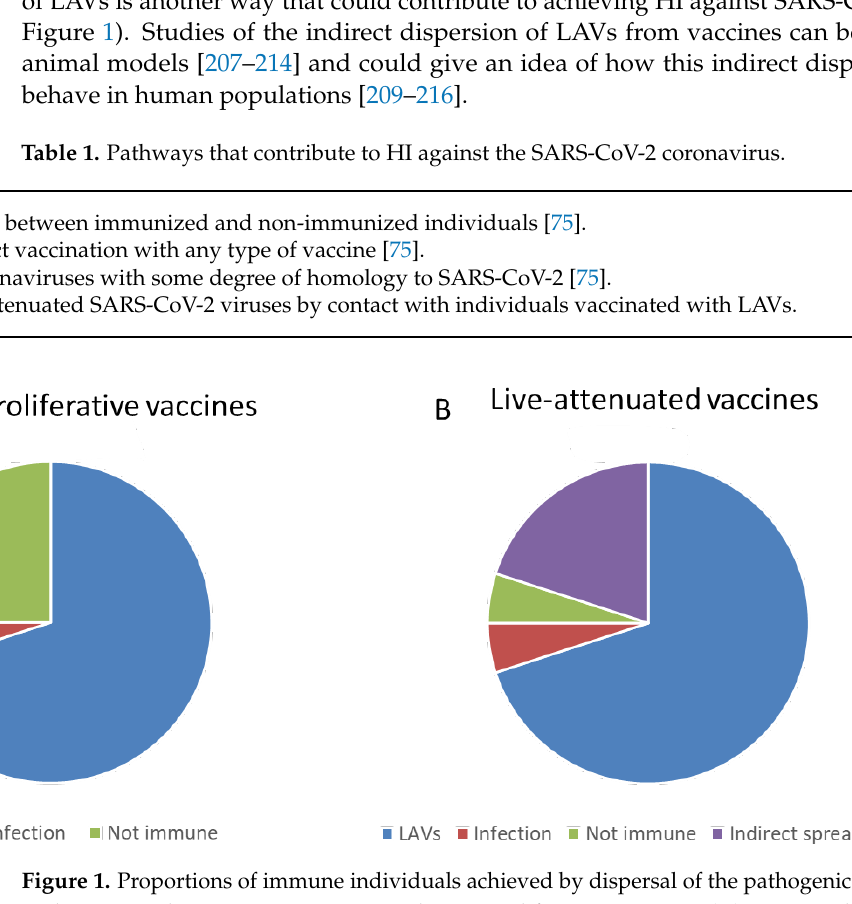
Figure 1. Proportions of immune individuals achieved by dispersal of the pathogenic microorgan- ism and non-mandatory immunization with non-proliferative vaccines ( A ) compared to propor- tions achieved by non-mandatory application of proliferating LAVs ( B ). The transmission of the live attenuated virus from LAVs vaccinated persons to close unvaccinated individuals induces in them a protective immune response increasing the proportion of immune individuals favoring HI.